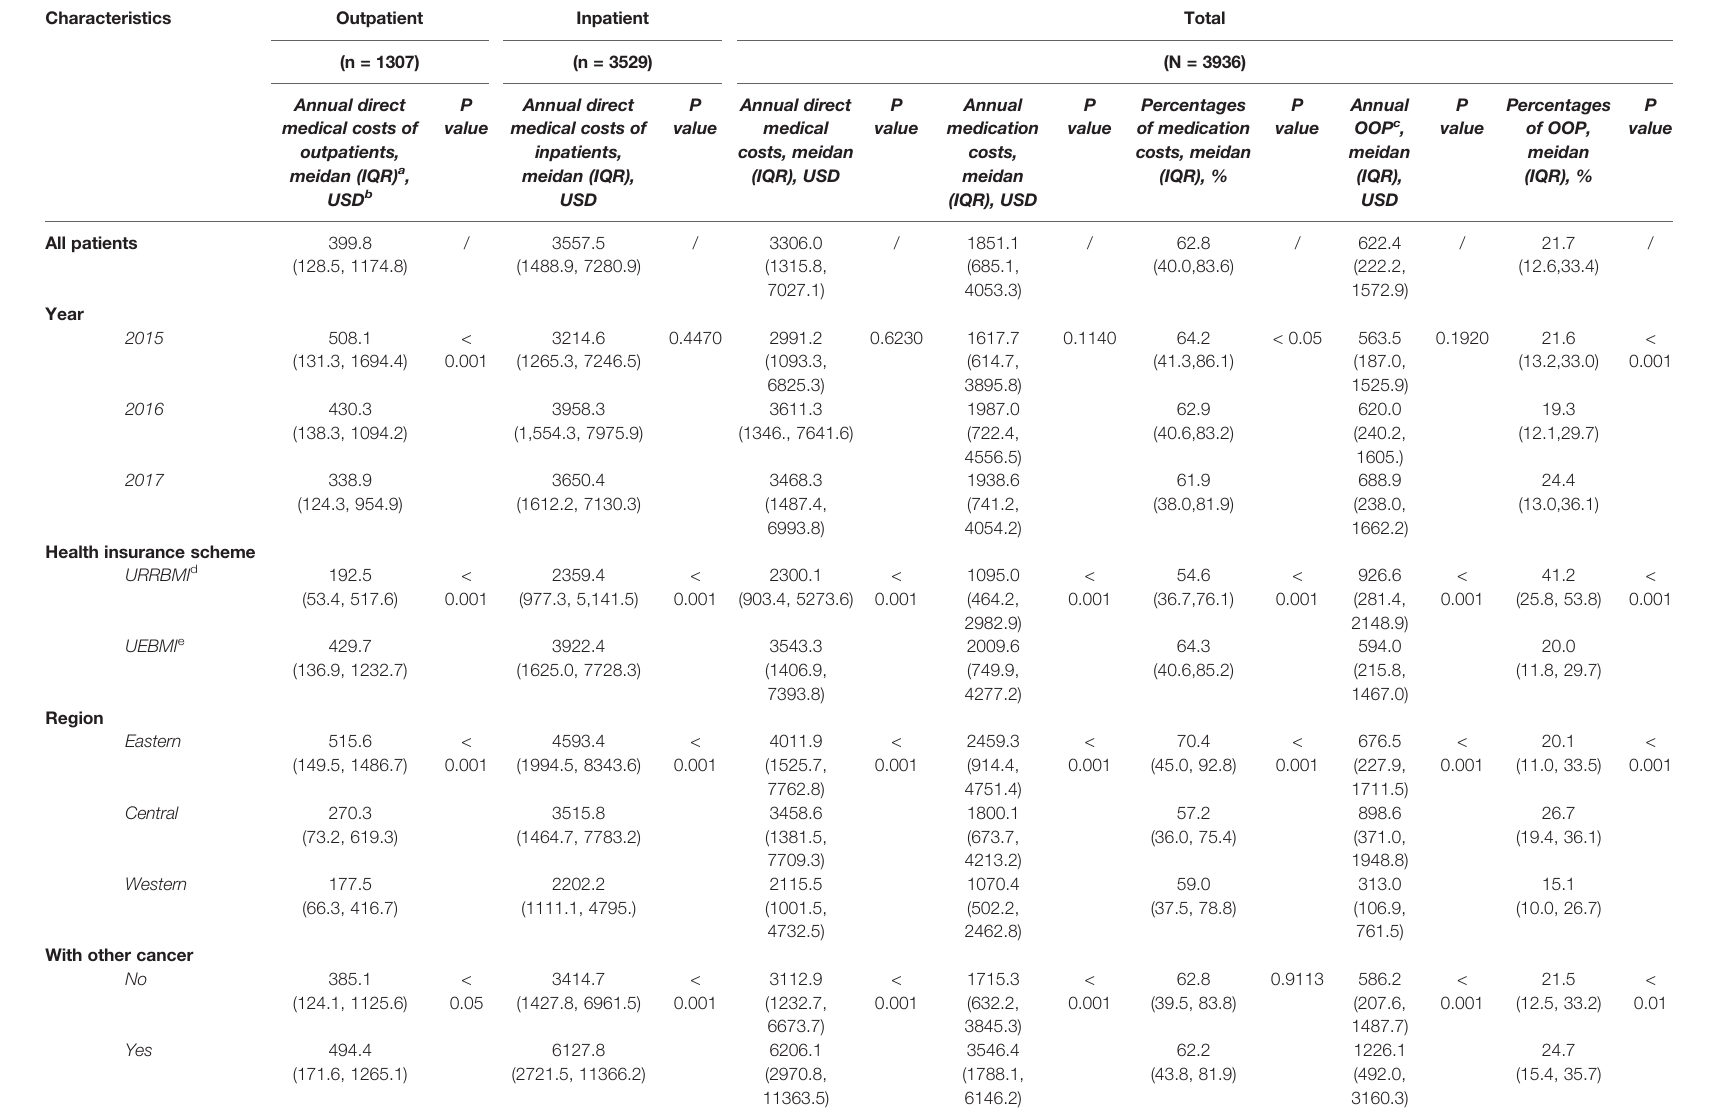
TABLE 2 | Annual direct medical costs and demographics of patients with prostate cancer in China between 2015 and